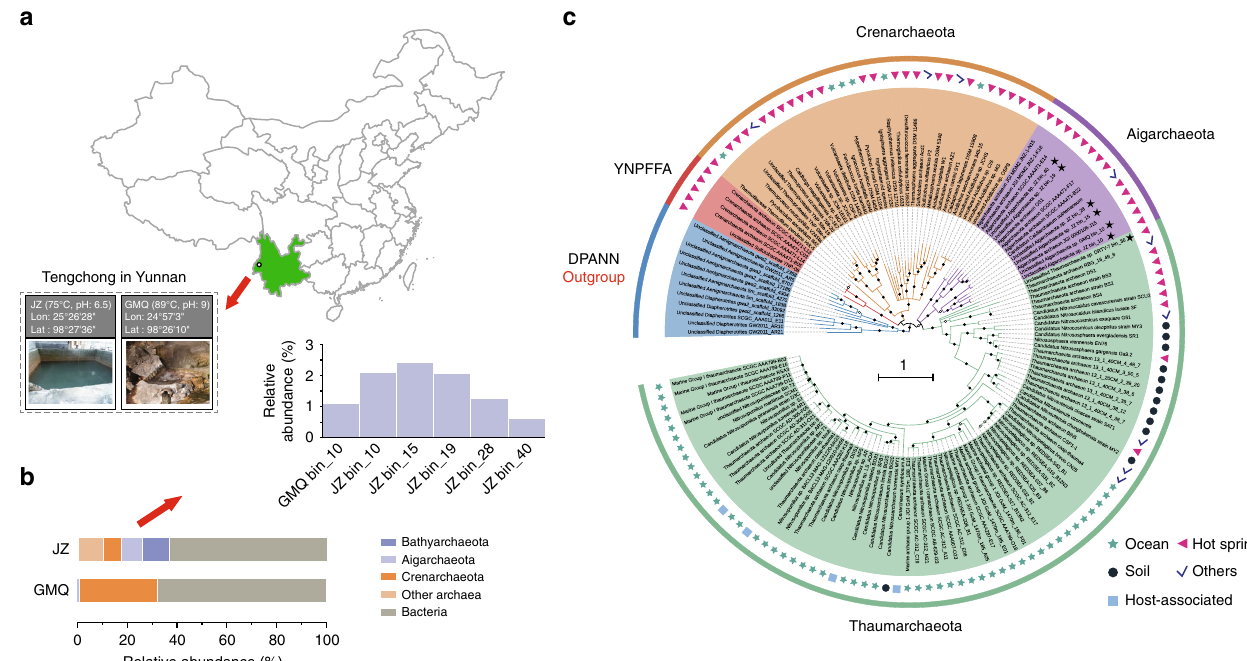
Fig. 1 The reconstructed genomes of Aigarchaeota. a Geographic locations of the two hot spring sites, JZ and GMQ, where sediment samples were collected. b Relative abundance of the six aigarchaeal genome bins recovered from metagenomes. c Phylogenetic placement of the bins. The tree was constructed based on the concatenated alignment of 16 ribosomal proteins. Nodes with bootstrap value ≥ 90 (70) are indicated as solid (hollow)